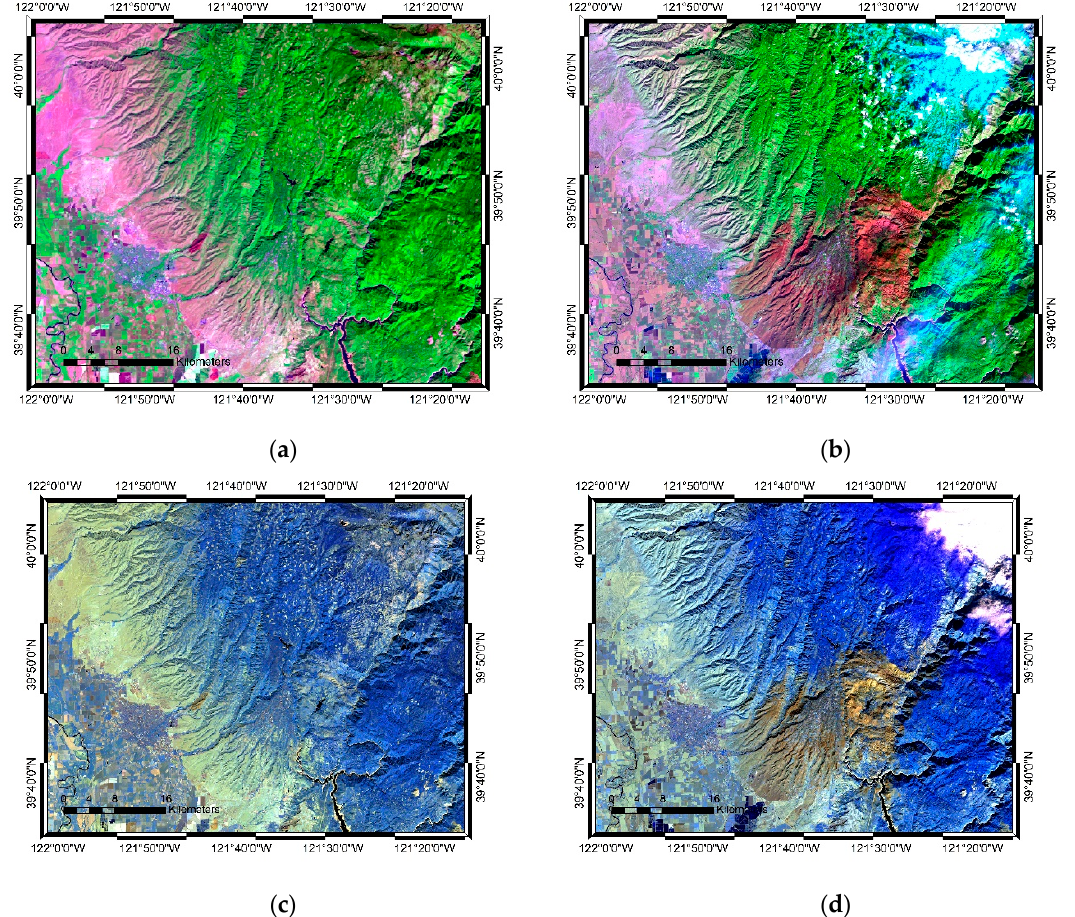
Figure 2. Pre ‐ and post ‐ wildfire event satellite imagery in false color combination captured by Figure 2. Pre- and post-wildfire event satellite imagery in false color combination captured by Landsat-8 Landsat ‐ 8 ( a ) on September 21, 2018, ( b ) on December 26, 2018, and Sentinel ‐ 2 ( c ) on November 6, ( a ) on September 21, 2018, ( b ) on December 26, 2018, and Sentinel-2 ( c ) on November 6, 2018, and ( d ) 2018, and ( d ) on December 31, 2018. on December 31,